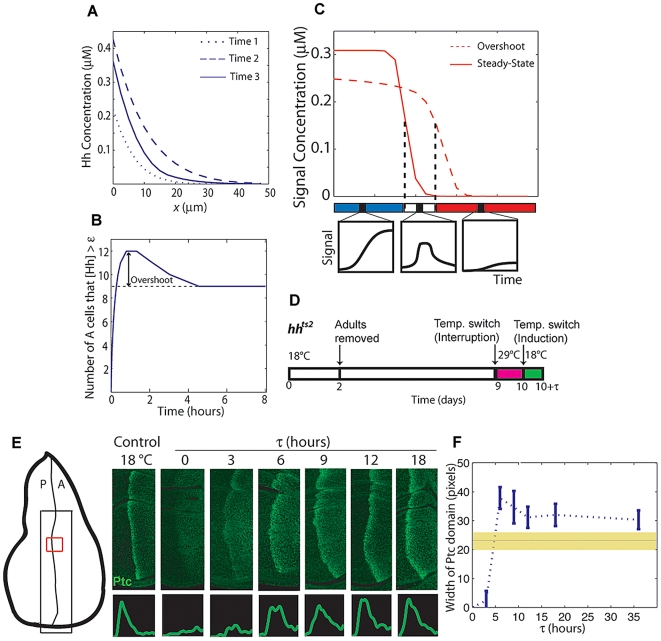
Temporal analysis of Hh signaling in vivo reveals the existence of a spatial overshoot.(A) Simulated profile of [Hh] gradient at three different time points: Time 1<Time 2<Time 3. The gradient transiently expands anteriorly (Time 2) and then refines towards its steady-state shape (Time 3). (B) Number of cells that experience higher concentrations of [Hh] than the ON/OFF switch threshold, ε, as a function of time based on the simulated [Hh] profiles. This diagram defines an overshoot, a spatial domain of cells that are exposed transiently to [Hh]. (C) The dashed and solid red lines represent the [Signal] profiles resulting from the “overshoot” and “steady-state” gradients. Cells experience three qualitatively different dynamic trajectories of [Signal] exposure depending on their spatial location (lower boxes). (D) Experimental setup to reinitialize the Hh gradient using a temperature sensitive hedghog allele (hhts2; see Materials and Methods for details). Induction at 18°C to induce Hh signaling was conducted for different intervals of time (τ). (E) Ptc immunostaining of hhts2 homozygous discs from the experiment described in (D) for different induction times τ compared to a disc from a larva raised solely at 18°C. The large box in the illustration shows the entire region imaged; the small red box corresponds to a sample region used to generate the profiles using Protocol S1, displayed in the bottom panels. Discs were fixed, immunostained, and imaged under identical conditions (see Materials and Methods). (F) Width of the Ptc domains as the Hh gradient is developed. At least four discs at each time point were used. Mean widths were computed, and error bars indicate standard deviations (see Protocol S1). Yellow area indicates the width range for Ptc in control discs at 18°C.